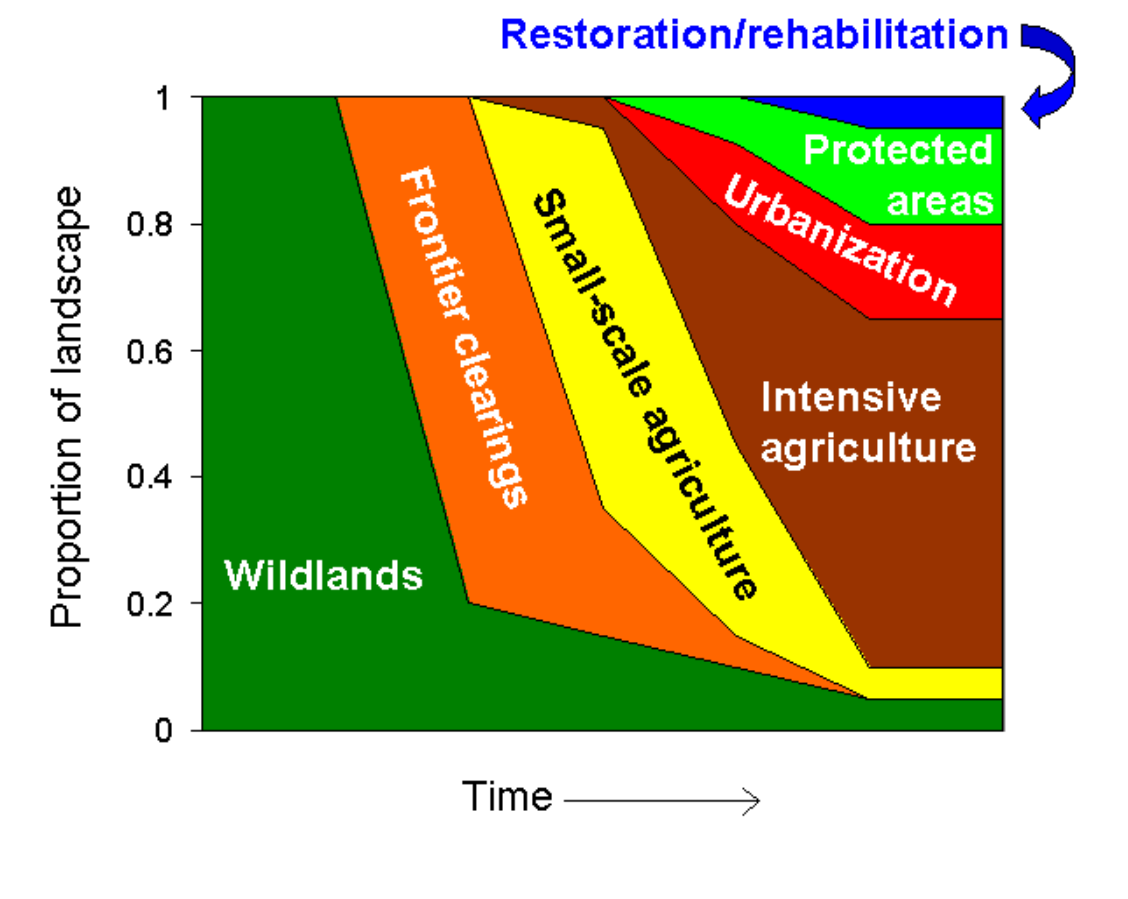
Fig. 3. Generalized schematic sequence of land-cover changes from before human settlement to the human domination of the landscape (adapted from DeFries et al.